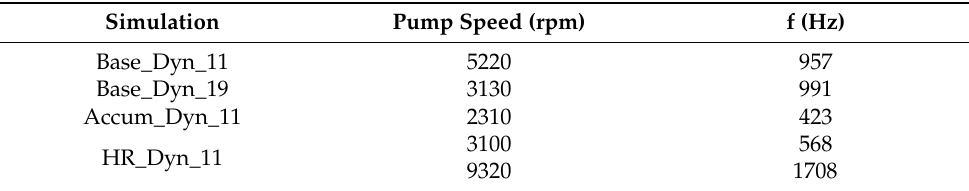
Table 6. Resonance pump speeds.